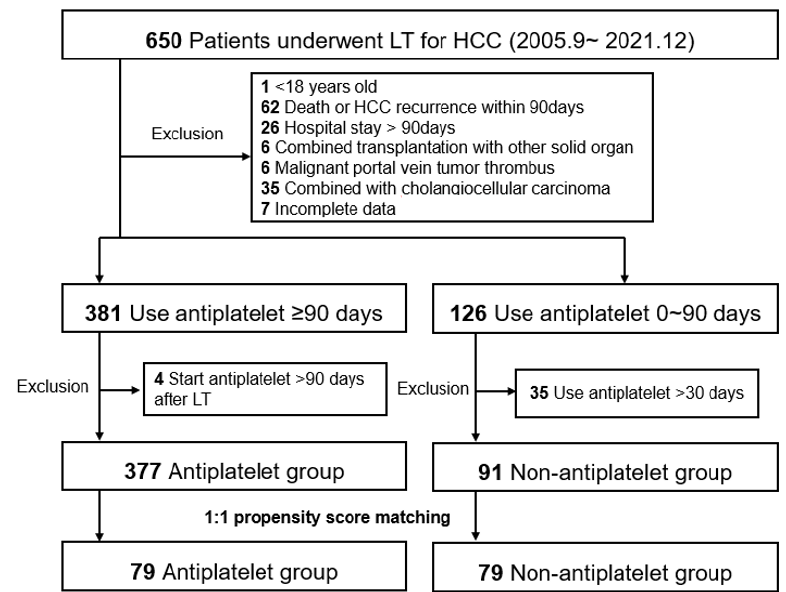
Figure 1. Study population. The flowchart diagram shows the patient selection, groupings, exclusion criteria, and propensity score matching cohorts. HCC, hepatocellular carcinoma; LT, liver transplantation. HCC, hepatocellular carcinoma; LT, liver transplantation.